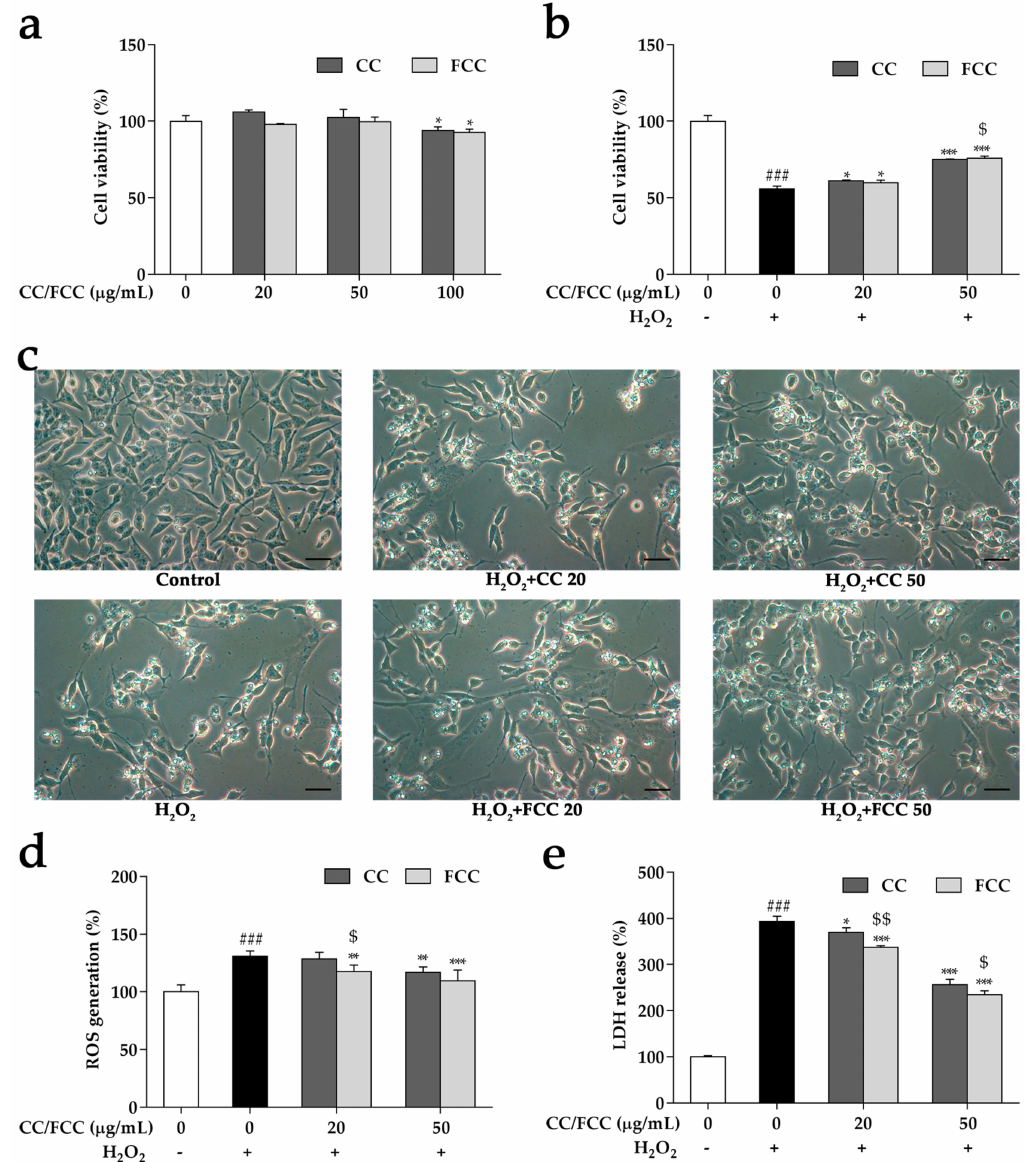
Figure 5. E ff ect of CC and FCC on morphology, cell viability and cytotoxicity in SH-SY5Y neuroblastoma cells. The ( a ) cell cytotoxicity and ( b ) cell viability were detected by 3-(4,5-dimethylthiazol-2-yl)-2,5-diphenyltetrazolium bromide (MTT). ( c ) Morphological changes (400 × , scale bar: 20 µ m) showed the cell viability was increased after CC or FCC pretreatment. ( d ) Reactive oxygen species (ROS) generation and ( e ) Lactate dehydrogenase (LDH) release caused by H 2 O 2 was significantly decreased by pretreatment with CC or FCC. “ + , -”: Cells were treated with or without H 2 O 2 . The data are expressed as mean ± SD, n = 3. ### p < 0.001 compared to the control cells and * p < 0.05, ** p < 0.01, *** p < 0.001 compared to H 2 O 2 treatment alone, and $ p < 0.05, $$ p <